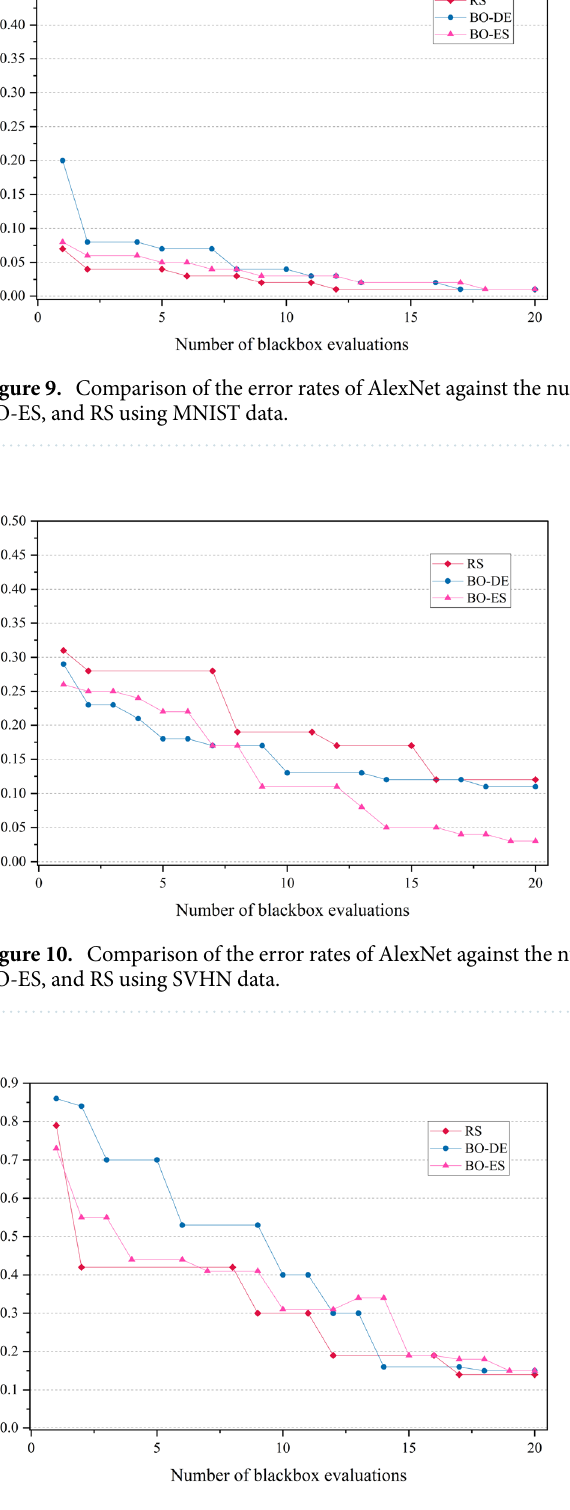
Figure 11. Comparison of how error rates of AlexNet evolve with the number of function evaluations for RS, BO-ES and BO-ES on CALTECH